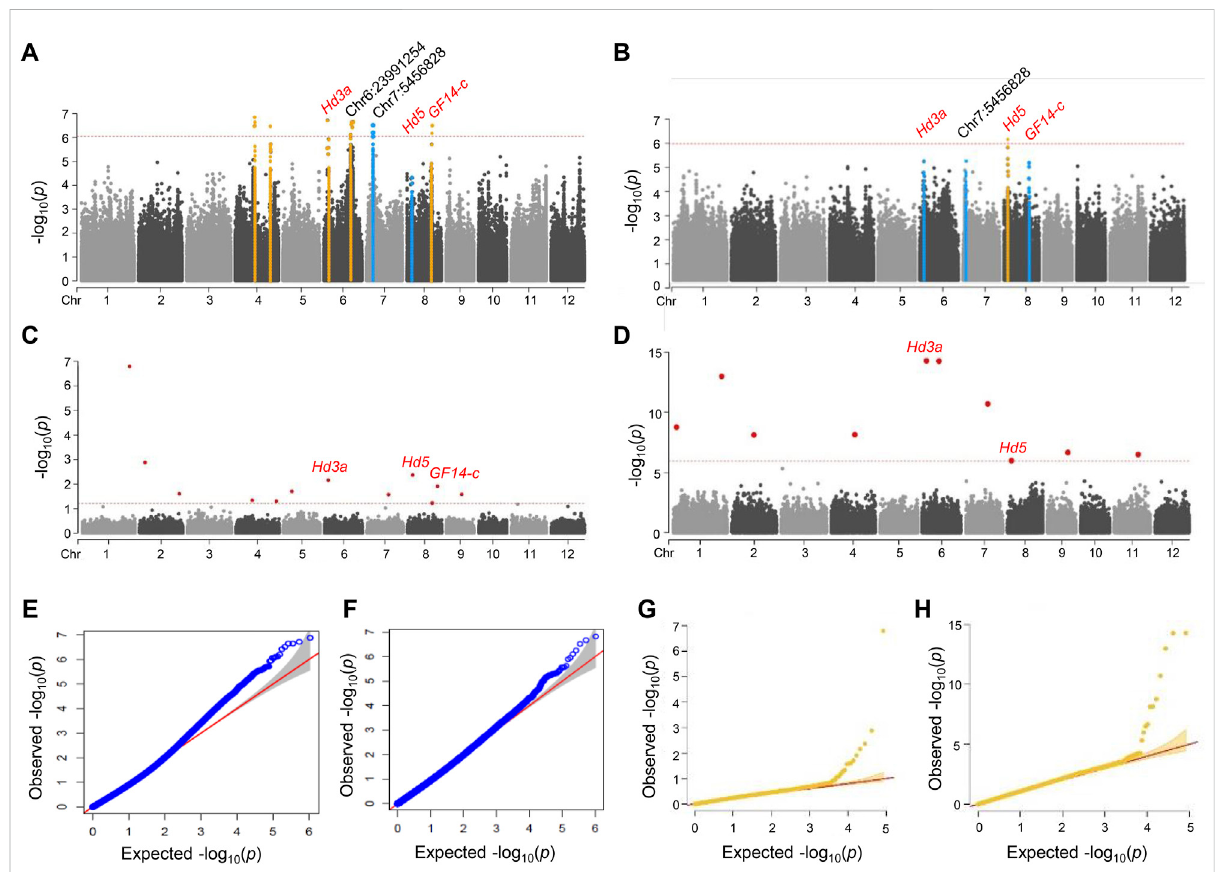
FIGURE 2 Manhattan and quantile-quantile plots for a GWAS of Hd phenotype in NK rice. (A – D) Manhattan plots of 2018 (A) and 2019 (B) in MLM model with GAPIT, and 2018. (C) and 2019. (D) in FarmCPU model with rMVP, respectively. Orange lines indicated signi fi cant SNPs correlated with Hd. Blue lines indicated major peaks not signi fi cantly correlated with Hd. Genome-wide signi fi cance threshold lines in MLM ( p < 4.32 × 10 – 7 ) and FarmCPU model ( p < 6.05 × 10 – 7 ) were shown as red dashed lines. Known and novel candidate genes are marked above lead SNPs. (E – H) Q-Q plot of 2018 (E) and 2019 (F) in MLM model with GAPIT and 2018 (G) and 2019. (H) in FarmCPU model with rMVP. For the Q-Q plots, the horizontal axis represents the expected -log 10 ( p ), and the vertical axis is observed -log 10 ( p ) of each SNP. The SNPs that had p -values deviated from the linear indicate reasonable positives.